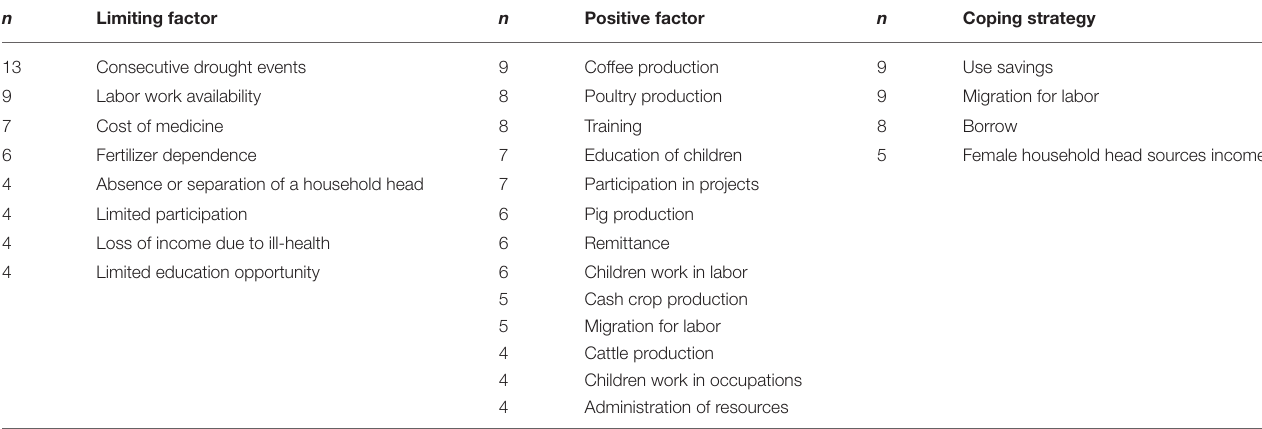
TABLE 3 | Self-identified limiting factors, positive factors (in the context of a change in well-being), and coping strategies mentioned during interviews with 24 participants, with count of mentions ( n ). n